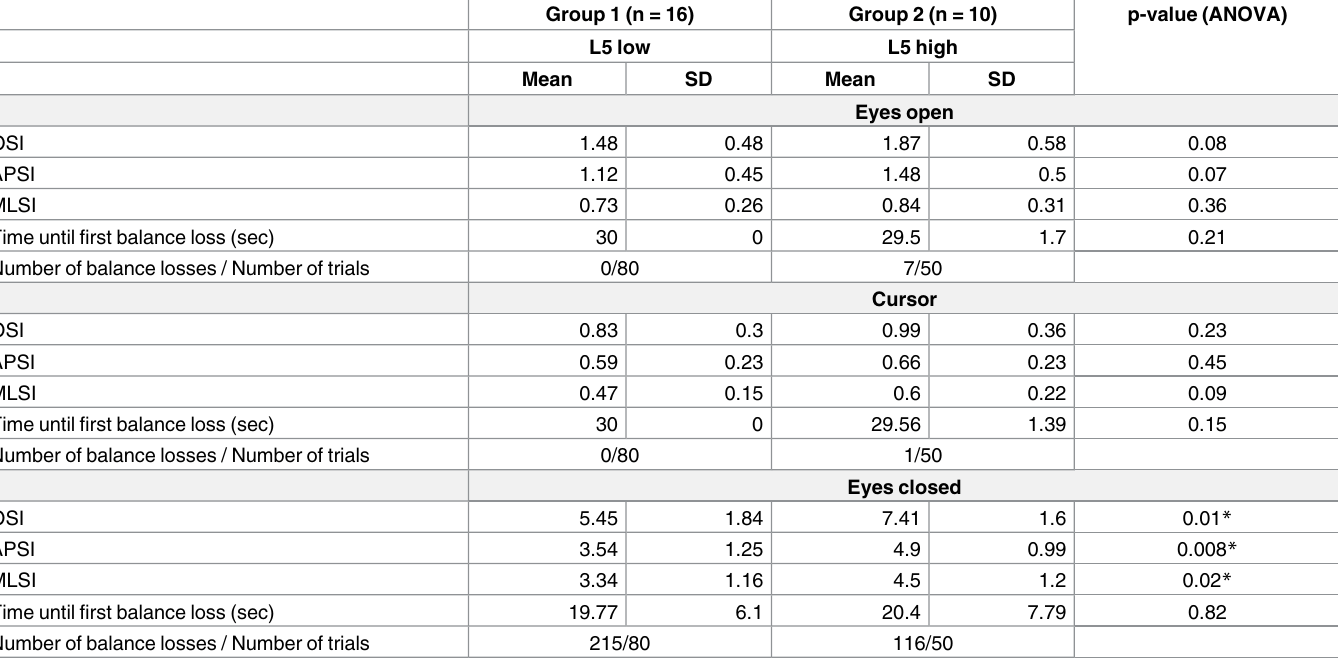
Table 3. Stability index score with stable platform levels (one 30 s test in level 1, 2, 3, 4, and 9. Dynamic test